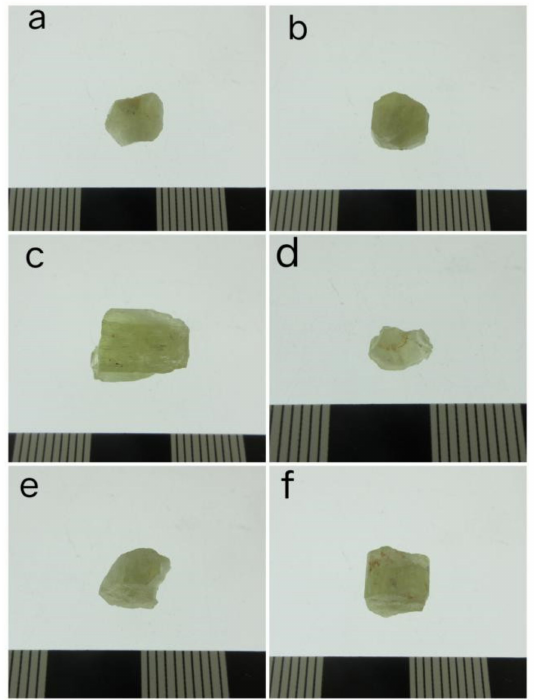
Figure 2. ( a – f ) Apatite crystals Moro-1 to Moro-6 from